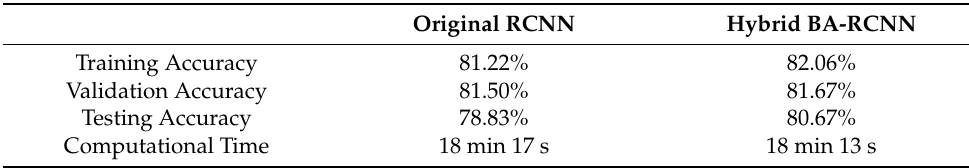
Table 7. Prediction accuracy and computational time for algorithms (first version).